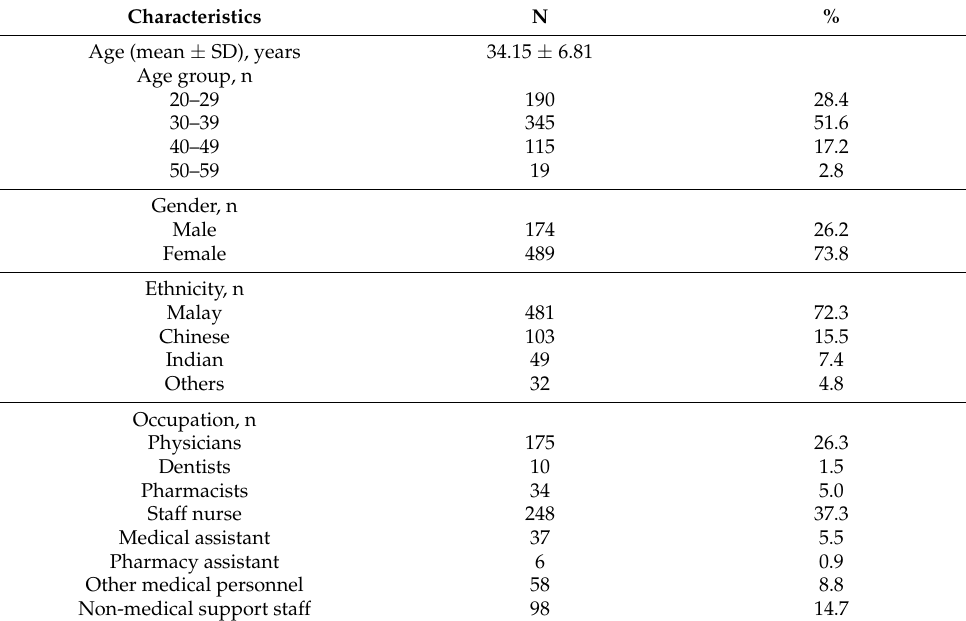
Table 1. Demographic characteristics of COVID-19 vaccines recipients (n = 670).